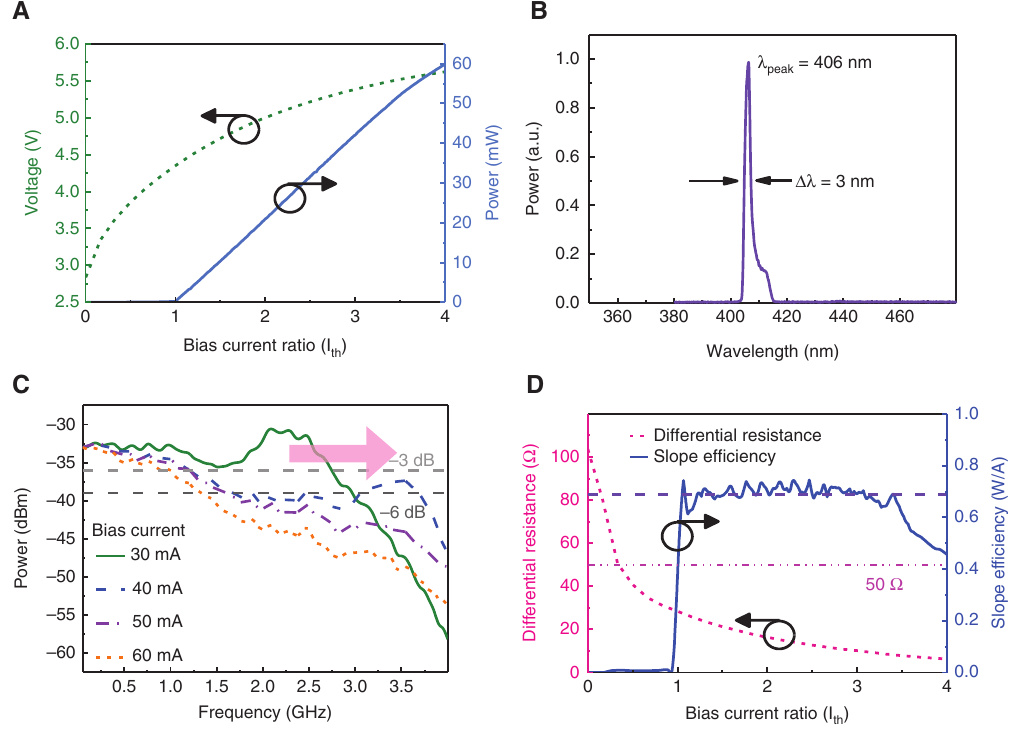
Figure 4: Lasing and modulating characteristics of the VLD. (A) P-I-V curve, (B) lasing spectrum, (C) frequency response, and (D) differential resistance and slope efficiency of